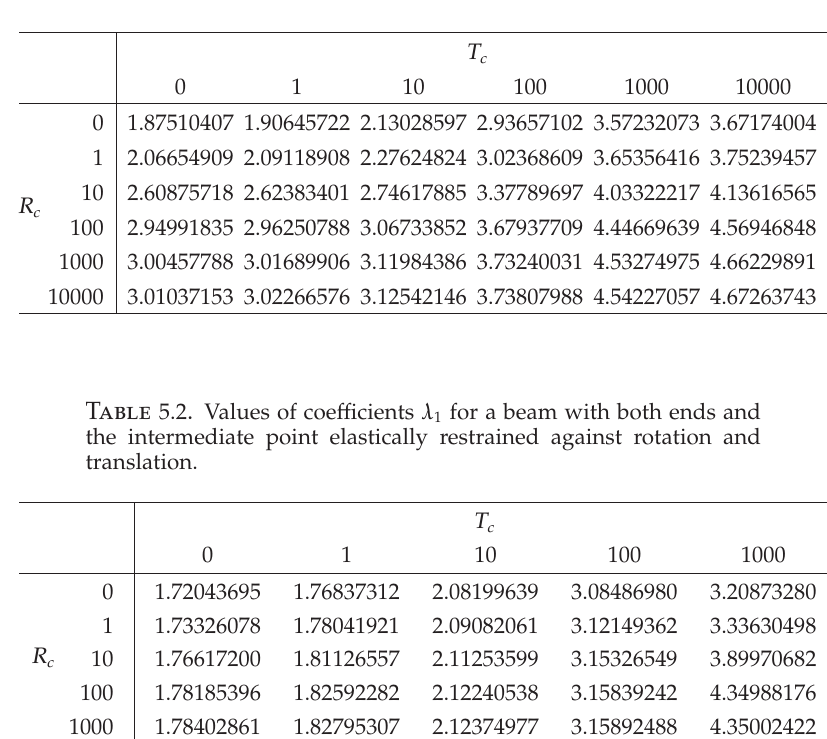
Table 5.1 . Values of the coe ffi cient λ 1 of a cantilever beam with an intermediate point elastically restrained against rotation and transla-